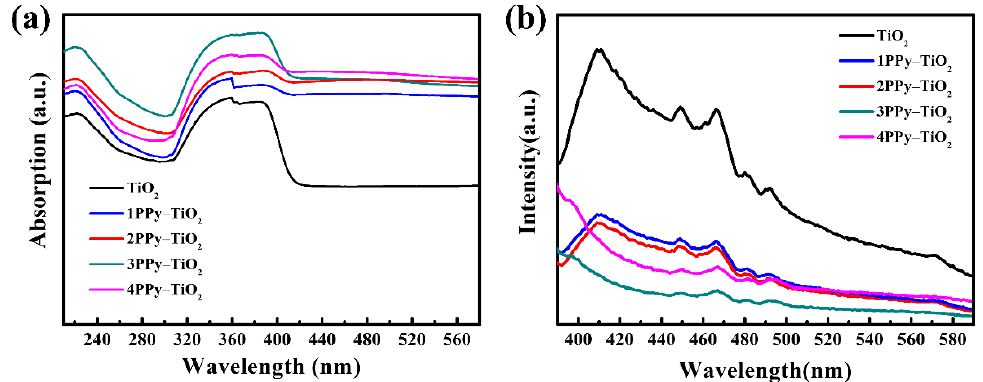
Figure 5. UV-Vis absorption spectra ( a ) and photoluminescence spectrum ( b ) of pure TiO 2 and nPPy-TiO 2 nanocomposites prepared by different deposition